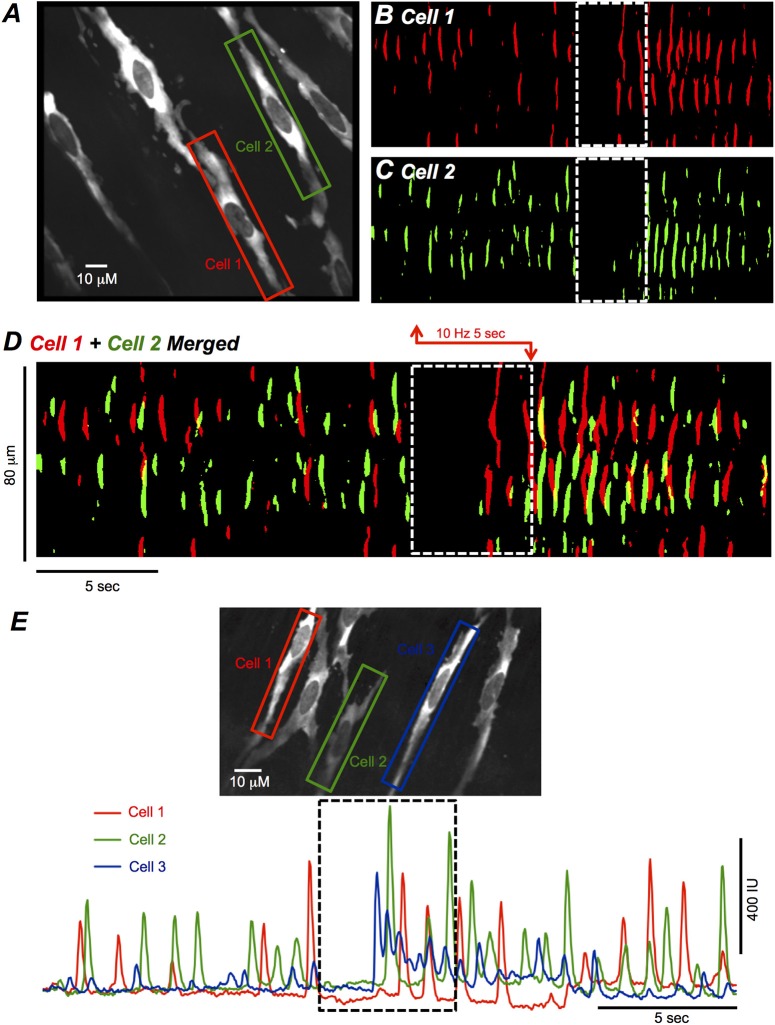
EFS effects on Ca2+ transients in multiple ICC-DMP. (A) FOV of ICC-DMP in situ recorded with a 60x objective showing 2 adjacent cells illustrated by the green and red ROIs. The activities of these cells are plotted as ST maps of cell 1 (B) and cell 2 (C) represented in (A) which have been uniformly colored to show all Ca2+ activity in the cell as either red (cell 1) or green (cell 2). These ST maps are merged in (D). (E) FOV of ICC-DMP in situ recorded with a 60x objective showing 3 cells illustrated by the red, green, and blue ROIs. The summated Ca2+ activity is plotted in the color-coded traces shown in the bottom half of the panel with the period of EFS (10 Hz, 5 s) indicated by the dashed black box. Note that all 3 cells in the FOV ceased activity at the initiation of EFS, but Ca2+ transients escaped from inhibition at different points in time during stimulation.